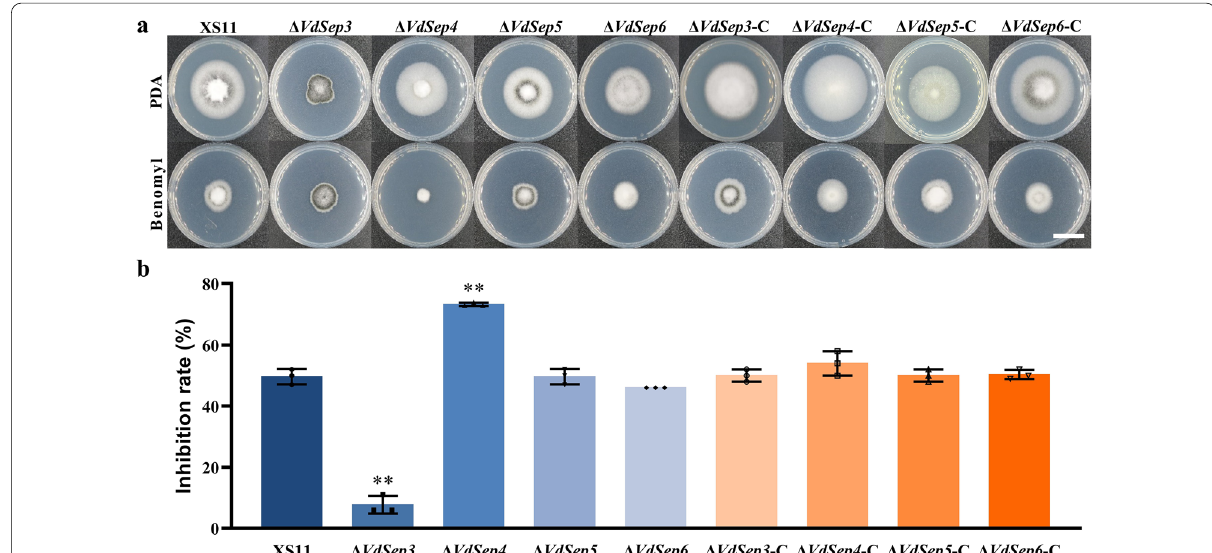
Fig. 7 Septins play different roles in response to benomyl. a Colony growth assay under stress by 0.6 μmol/L benomyl at 25 °C for 7 days. Bar 2 cm. b Column diagram showing growth inhibition in a . Error bars represent standard deviation based on three independent replicate = experiments (**, P <